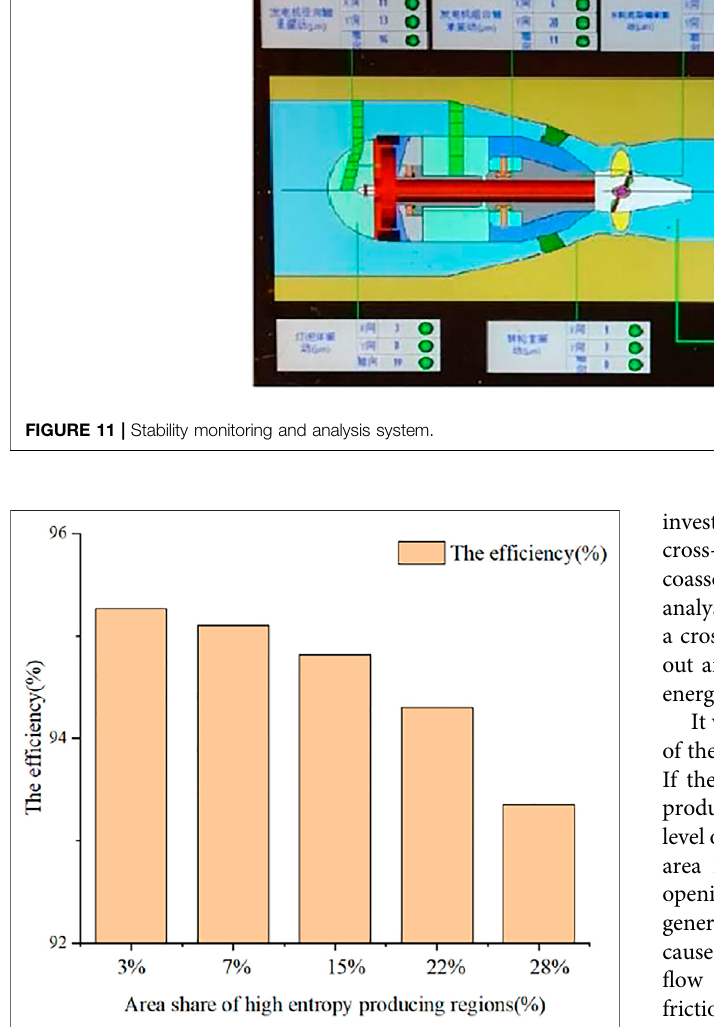
Frontiers in Energy Research |